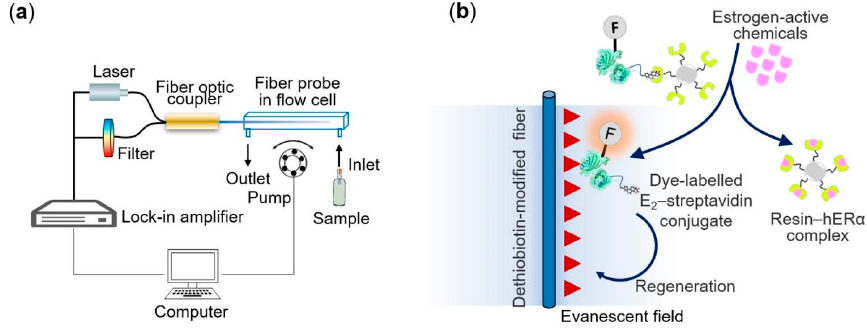
Figure 5. ( a ) Schematic of the optical-fiber biosensing platform. ( b ) Sensing scheme of the estrogen receptor-based biosensor using triple functional fluorescein-labelled E2–STV conjugates for estrogenic activities quantification. Reproduced from [33].